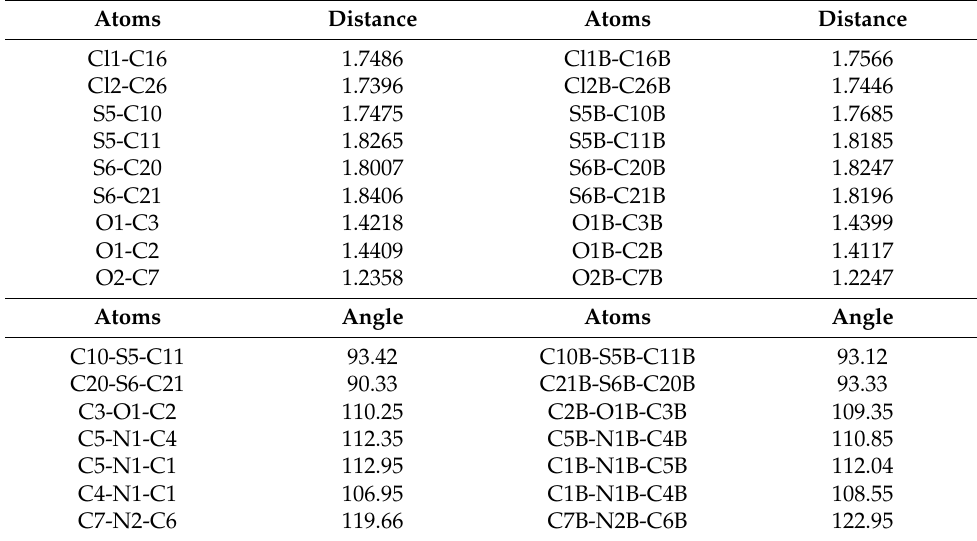
Table 2. Selected bond lengths (Å) and angles ( ◦ ) for 5a .